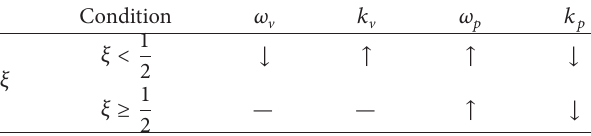
Table 2: Law by which 𝜉 affects the key points of the equivalent